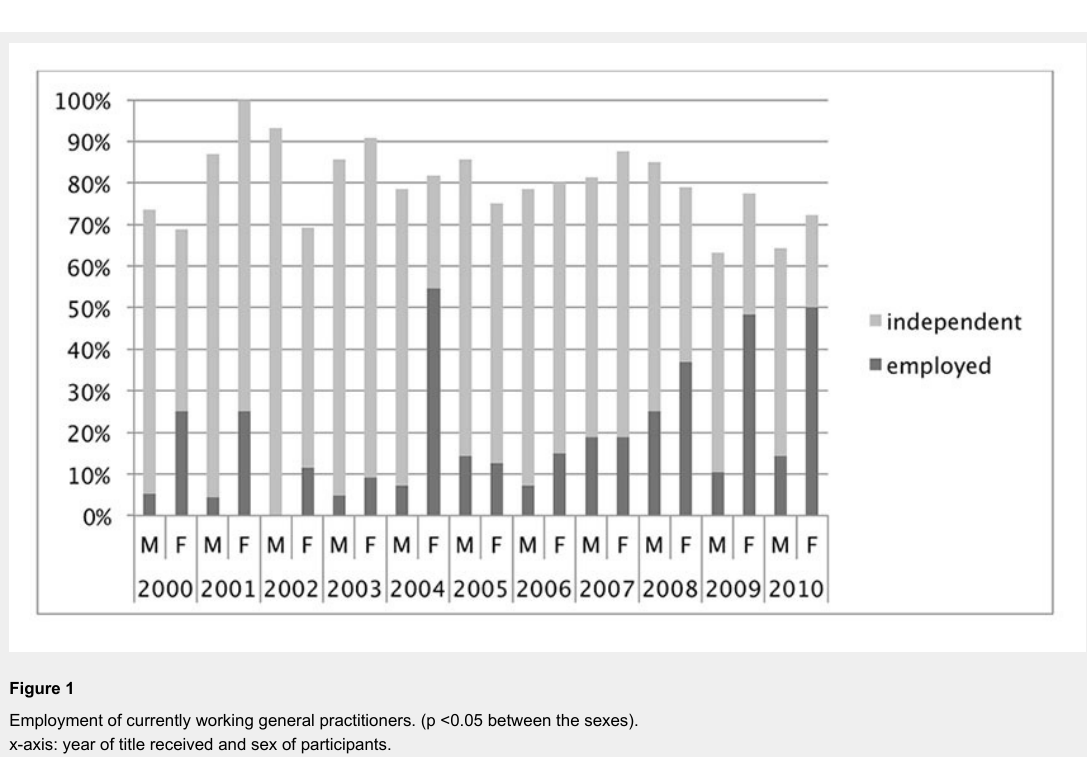
Employment of currently working general practitioners. (p <0.05 between the sexes). x-axis: year of title received and sex of participants. y-axis:the height of the bar represents the percentage of the participants that were currently working in general